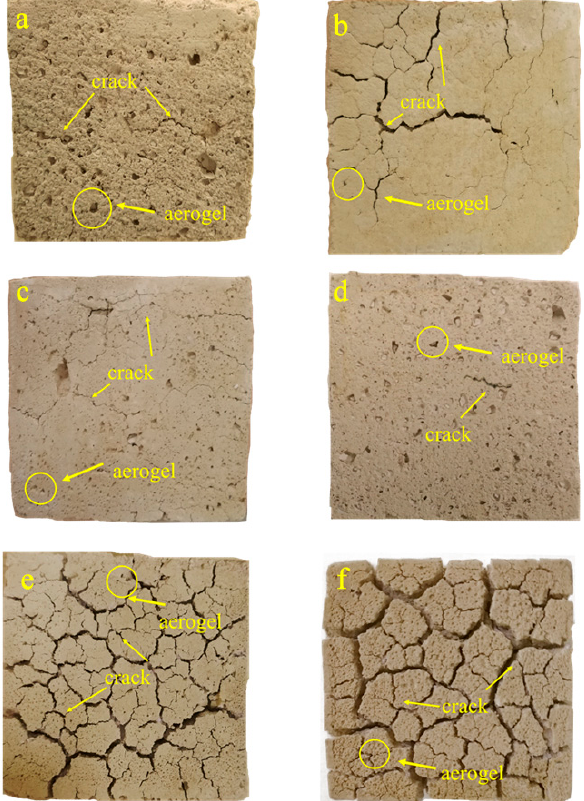
Figure 6. The ACP morphology after the simulated tunnel fire under different early curing regimes: ( a ) ACP morphology under 10 C; ( b ) ACP morphology under 20 C; ( c ) ACP morphology under